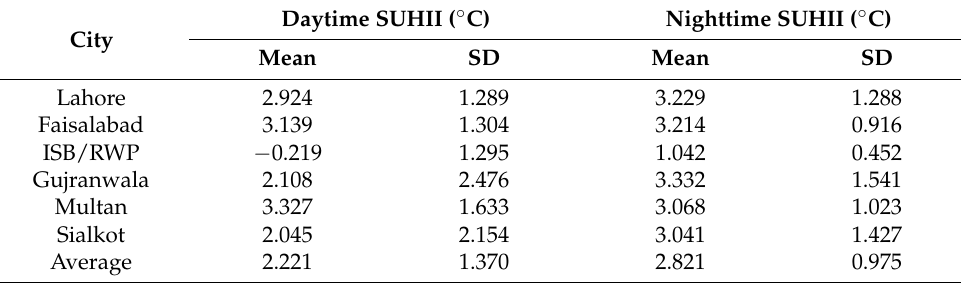
Table 3. Statistical summary of daytime and nighttime SUHII for Punjab